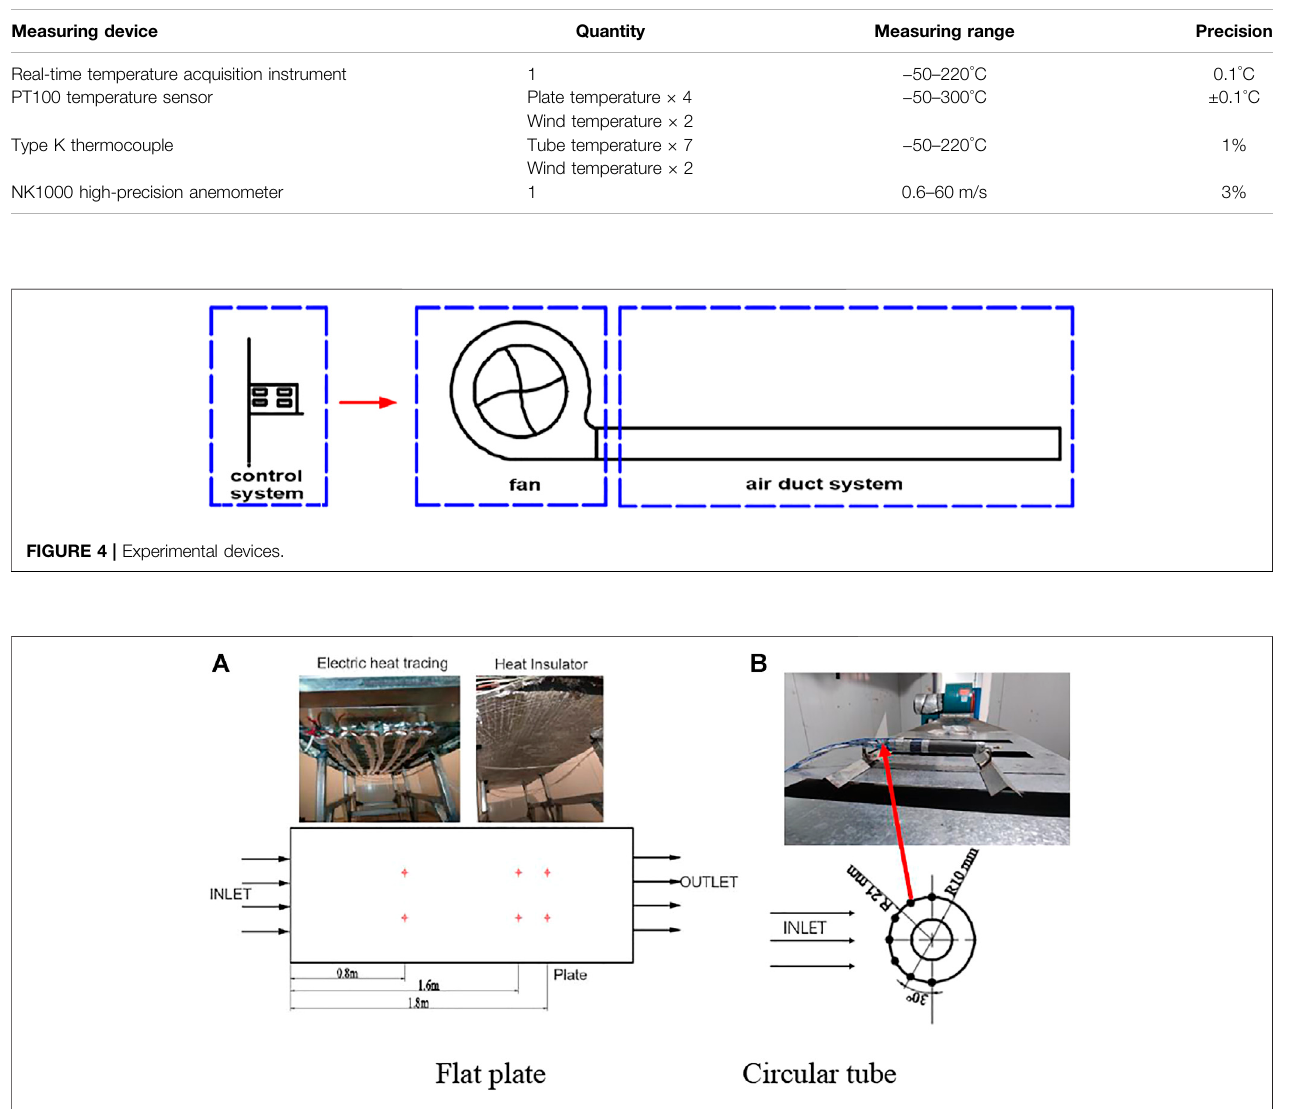
FIGURE 5 | Arrangement diagram of measuring points. (A) Flat plate and (B) Circular